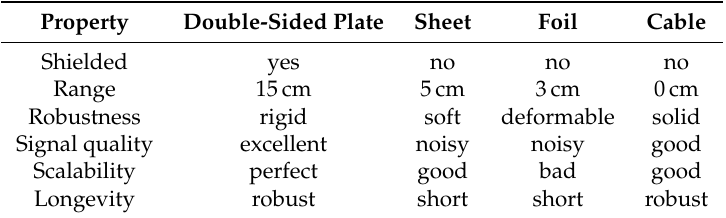
Table 1. Comparison of electrode materials. The option of shield is of vital importance to increase the sensing range and robustness. Therefore, the choice of use in this work is the double-sided copper plate with sensing and shielding